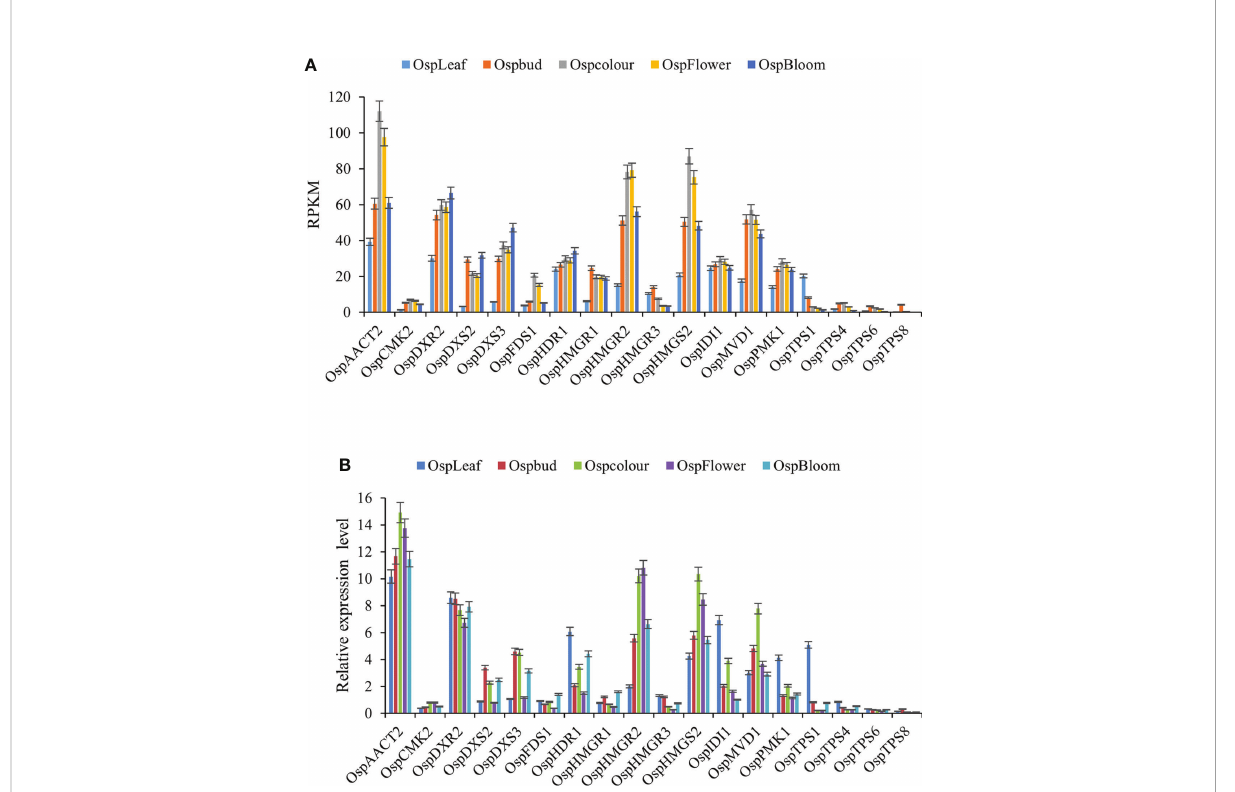
FIGURE 7 Transcript pro fi les of 18 selected genes in ‘ Taihang Mingzhu ’ as determined by qRT-PCR analysis. (A) Transcript levels of 18 genes based on reads per kb per million reads (RPKM) value. (B) Relative transcript levels of 18 genes as determined by qRT-PCR analysis. Error bars represent standard deviation from three